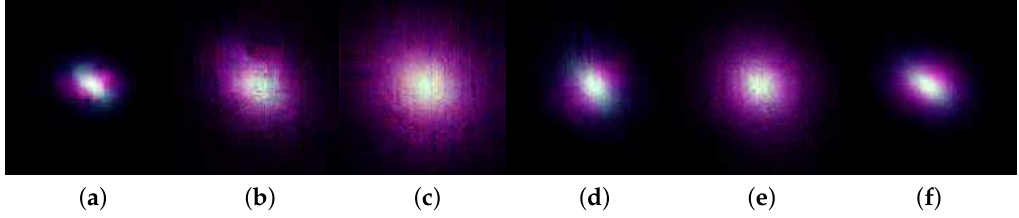
Figure 10. Generated images of bearing fault data using the Wasserstein generative adversarial networks with gradient penalty on the DCGAN architecture model (DCWGAN-GP). ( a ) Contaminant,